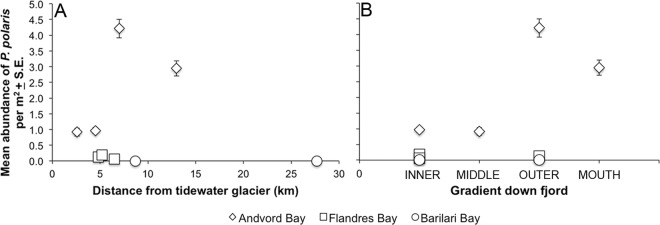
Abundance of the trachymedusa Ptychogastria polaris in Andvord, Flandres and Barilari Bays.Data are plotted (m-2) as a function of (A) distance to the nearest tidewater glacier, and (B) position in basins down fjord.